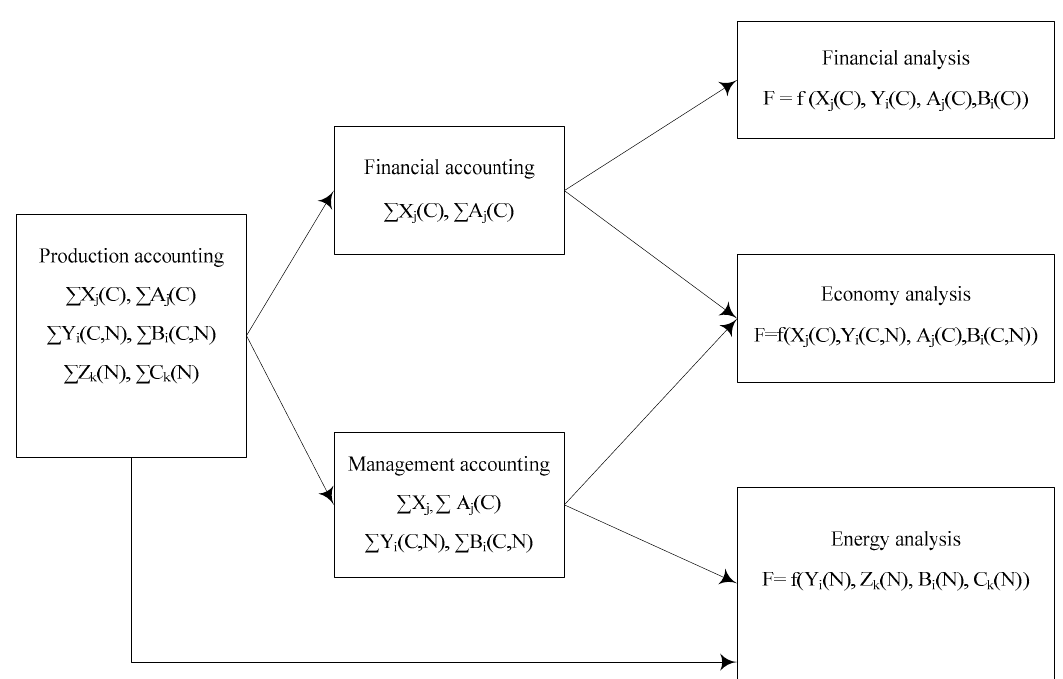
Figure 2. Scheme of information streams between different types of accounts and analysis.